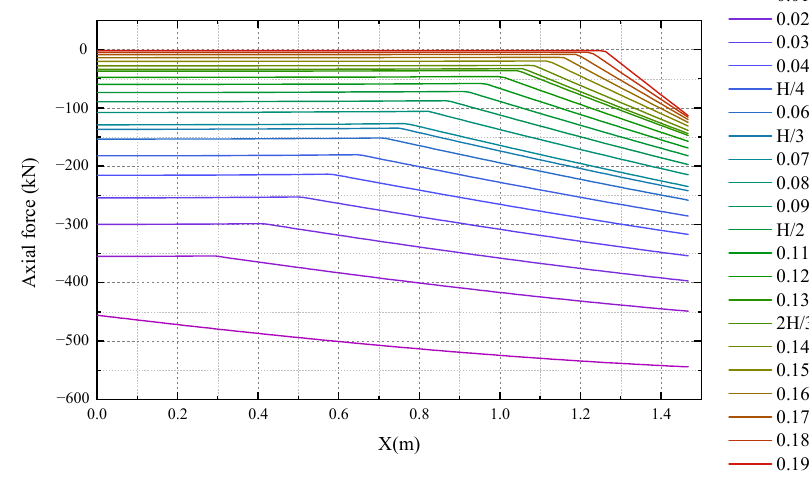
Figure 16. Axial force.